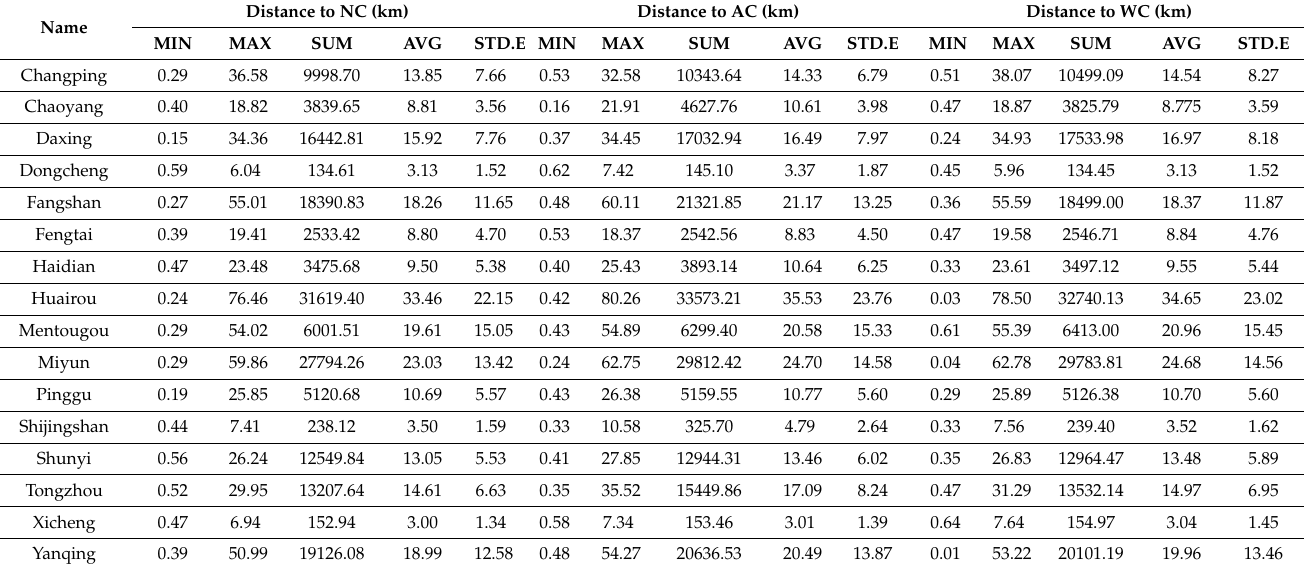
Table 1. Comparison of statistics between the distance to NC, AC, and WC from each